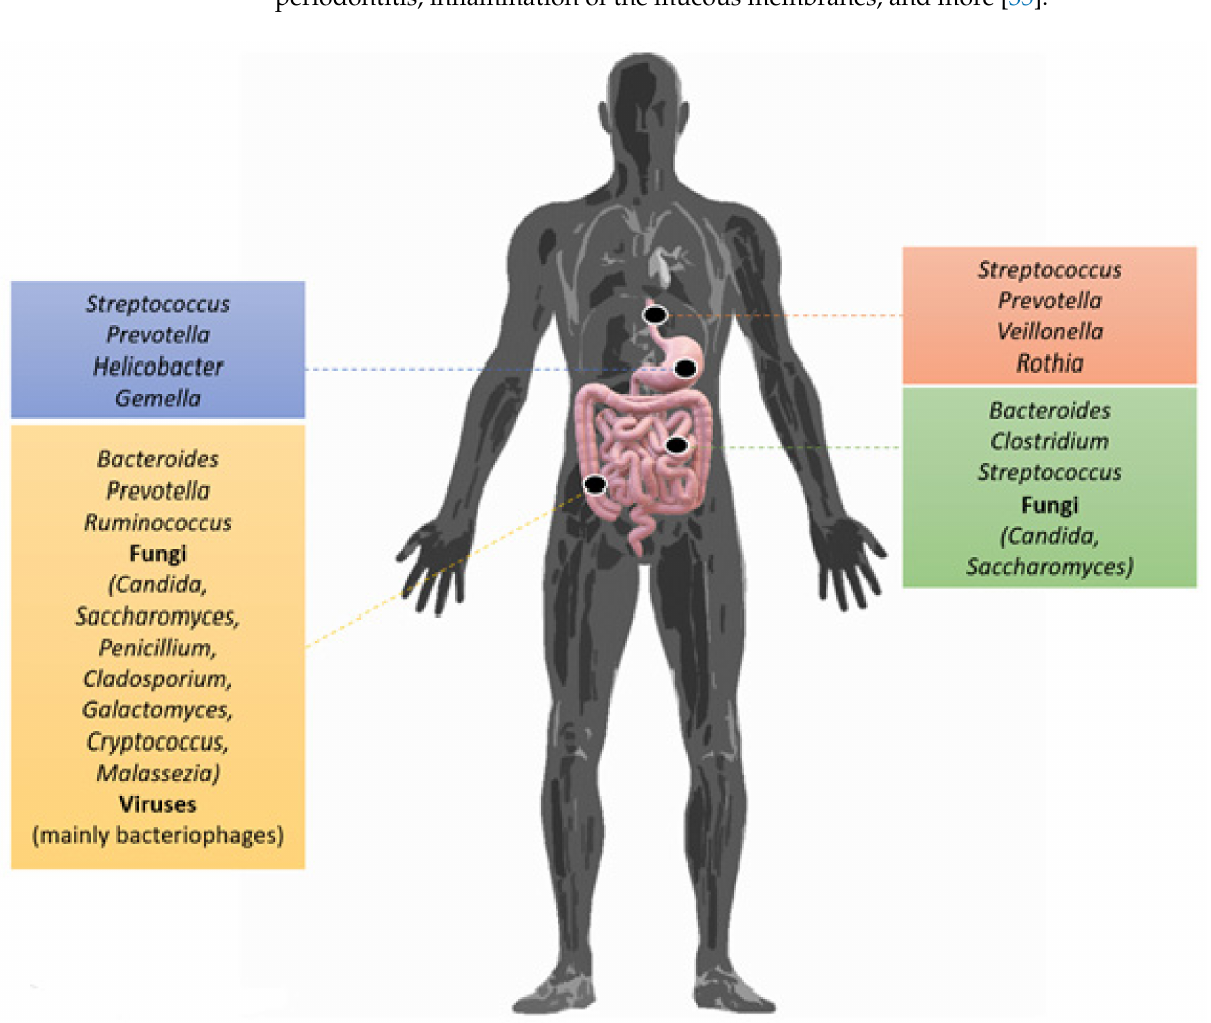
Figure 1. The gastrointestinal tract has a variety of favorable or less favorable habitats for micro- organisms, extending from the oral cavity to the anus. Furthermore, differences in conditions, due to the physiology or the substrates present (e.g., those deriving from food), can act as microbial selection “forces” for each environment. Along the gastrointestinal tract, micro-organisms are predominantly found in the large intestine and ileum, while a smaller number are observed in the jejunum. The stomach and duodenum are colonized by unique species [36,37]. Despite various difficulties, studies have shown that the human gastrointestinal system is dominated by two phyla: Bacillota and Bacteroidota [38]. Credit: Original figure by I.A.